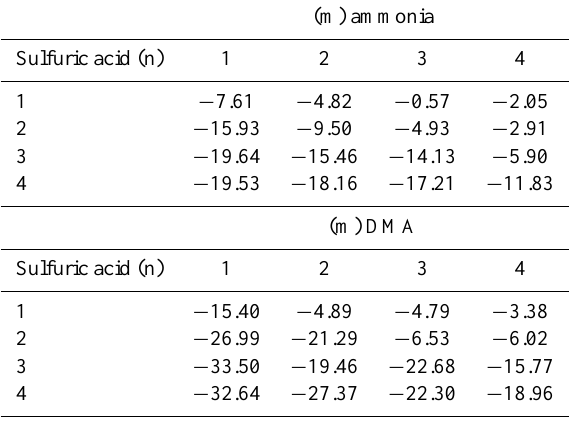
Table 5. Gibbs free energy for the reaction ((H 2 SO 4 ) n (NH 3 /